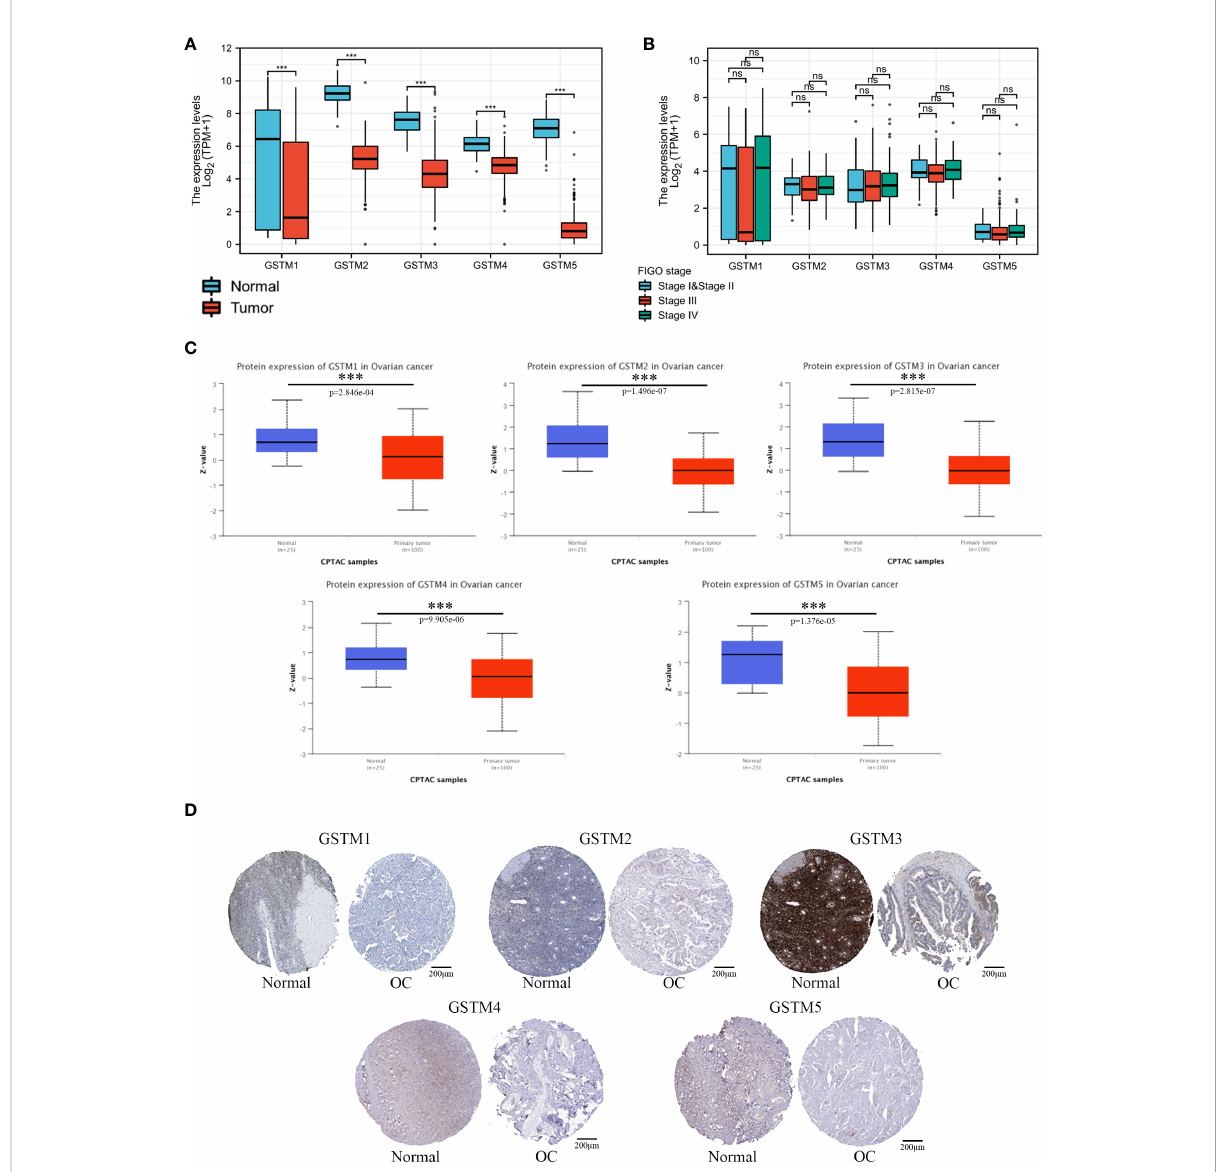
FIGURE 3 The GSTMs expression in OC. (A) The mRNA level of GSTMs in OC samples and normal ovary samples based on TCGA and GETx database. (B) The mRNA level of GSTMs in different FIGO stage OC samples. (C) The protein level of GSTMs in OC samples and normal ovary samples based on CPTAC database. (D) The GSTM protein expression in OC samples and normal ovary samples based on HPA database. ***p < 0.001 ns, means No statistical signi fi